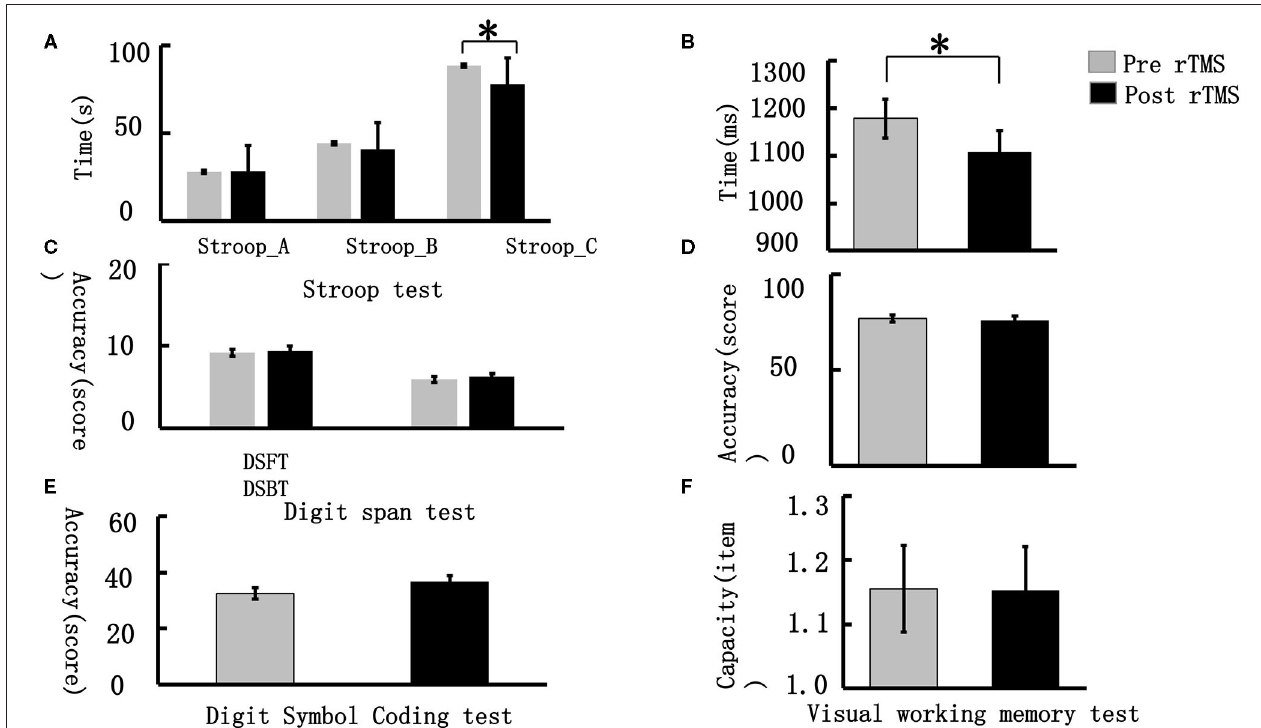
FIGURE 2 | Visual working memory behavioral performance. (A) represents the performance difference between pre- and post-stimulus in the word-Stoop, the color-Stroop and word-color Stroop tests (from left to right); (B) demonstrates the reaction time difference during the VWM task between the pre- and post-stimulus periods; (C) illustrates the performance differences between the pre- and post-stimulus during the Digit Span Forward test (DSFT) and Digit Span Backward test (DSBT); (D) demonstrates the accuracy differences during the VWM task between the pre- and post-stimulus periods; (E) represents the performance differences between the pre- and post-stimulus periods in the Digit Symbol Coding test; (F) demonstrates the capacity difference during the VWM task between the pre- and post-stimulus periods. * p < 0.05, ** p <